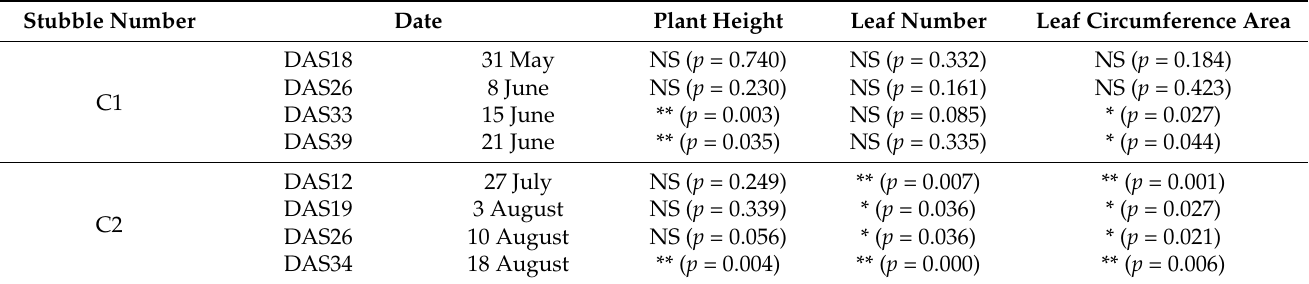
Table 1. Effect of IPS on growth and development of